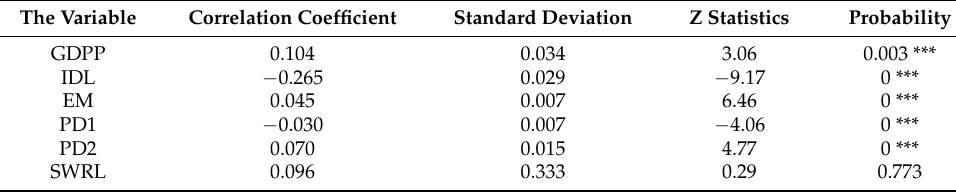
Table 5. The Tobit regression results of factors affecting China’s WRM performance. The Variable Correlation Coefficient Standard Deviation Z Statistics Probability